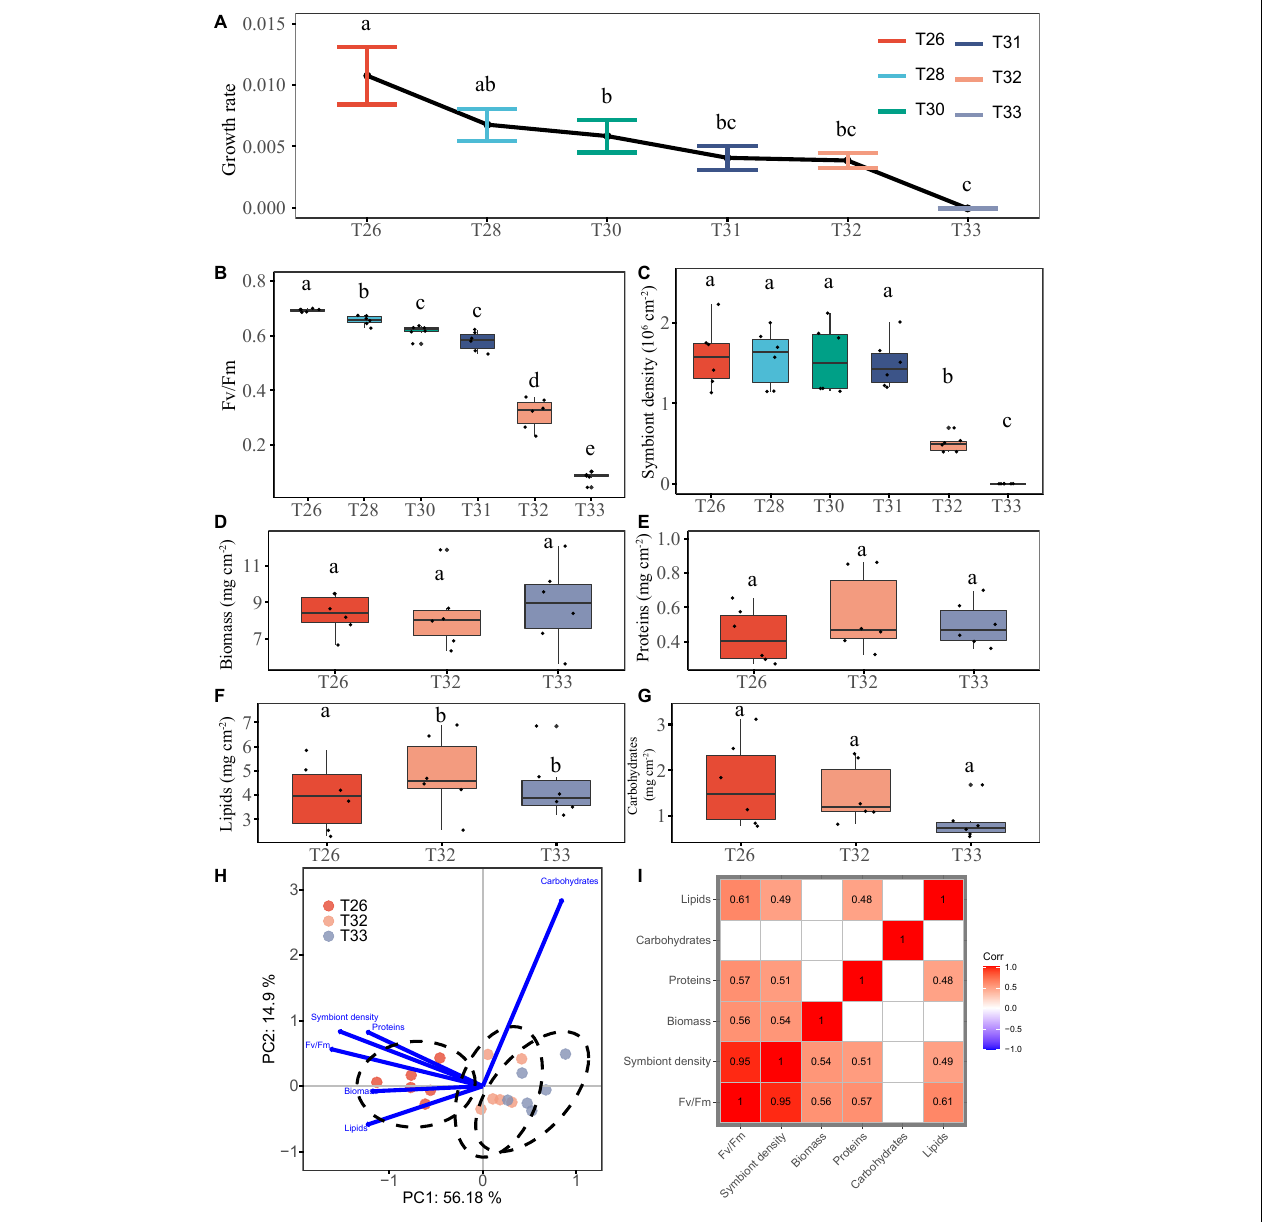
FIGURE 2 | Growth and physiological parameters of coral treated with elevated temperature. (A) Specific growth rate. (B) Photosynthetic efficiency (Fv/Fm). (C) Symbiot density. (D) Biomass. (E) Protein. (F) Lipid. (G) Carbohydrate. (H) PCA. (I) Correlation analysis. Data are expressed as mean ± SEM ( n = 6). Different lowercase letters denote significant differences from different treatments ( P <